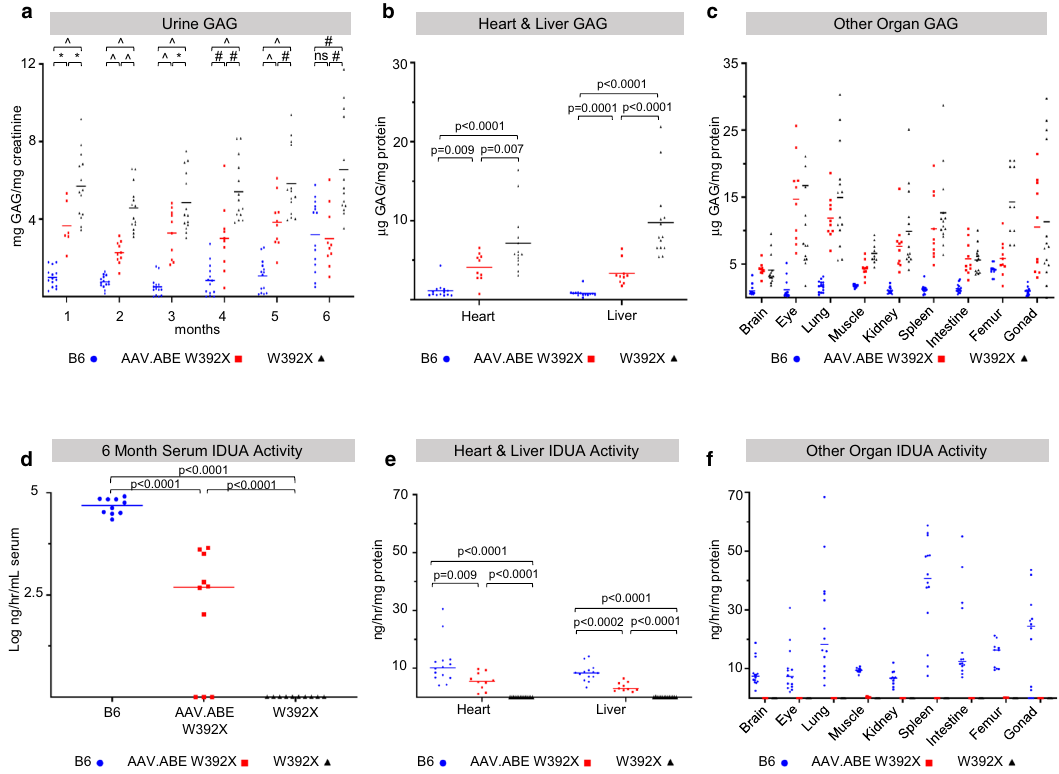
Fig. 2 Durable improvement in biochemical parameters in Idua-W392X mice following in utero base editing. a Urine GAGs were measured monthly in B6 ( N = 14), Idua- W392X mice prenatally injected with AAV.ABE.Idua ( N = 10 except for month 1, N = 6), and uninjected Idua- W392X mice ( N = 14). b , c Tissue GAGs were measured at 6 months of age in the heart and liver ( b ) and other indicated organs ( c ) in B6 ( N = 14, except for muscle/femur N = 10), prenatally injected mice ( N = 10), and uninjected mice ( N = 14, except eye, N = 13; and muscle/femur N = 10). d Serum IDUA activity was measured at 6 months of age in B6 ( N = 10), prenatally injected mice ( N = 10), and uninjected mice ( N = 10). e , f Tissue IDUA activity was measured at 6 months of age in the heart and liver ( e ) and other indicated organs ( f ) in B6 ( N = 14, except for muscle/femur N = 10), prenatally injected mice ( N = 10), and uninjected mice ( N = 14, except for muscle/femur N = 10). ^ p < 0.0001; # p < 0.001; * p < 0.05. Exact p values outlined in Supplementary Table 1. Wilcoxon test for multiple comparisons used to assess urine GAG months 1 – 3, liver GAG, and heart and liver IDUA activity. All remaining statistical analyses used Student ’ s t -test with α = 0.05. All tests two-sided. GAG glycosaminoglycans, IDUA α - L -iduronidase. AAV.ABE, represents mice injected with AAV.ABE. Idua. Source data are provided as a Source Data fi for on-target editing ef fi ciency in genomic DNA, IDUA enzyme activity, and GAG level. NGS demonstrated an on-target correction rate of ~1.65% (Fig. 1c) which was associated with detectable bicep IDUA enzyme activity (~3.2% of the normal IDUA activity in bicep muscles in B6 controls) compared to undetectable levels in W392X controls. This was consistent with a signi fi cant reduction in bicep GAG levels in prenatally AAV.ABE.